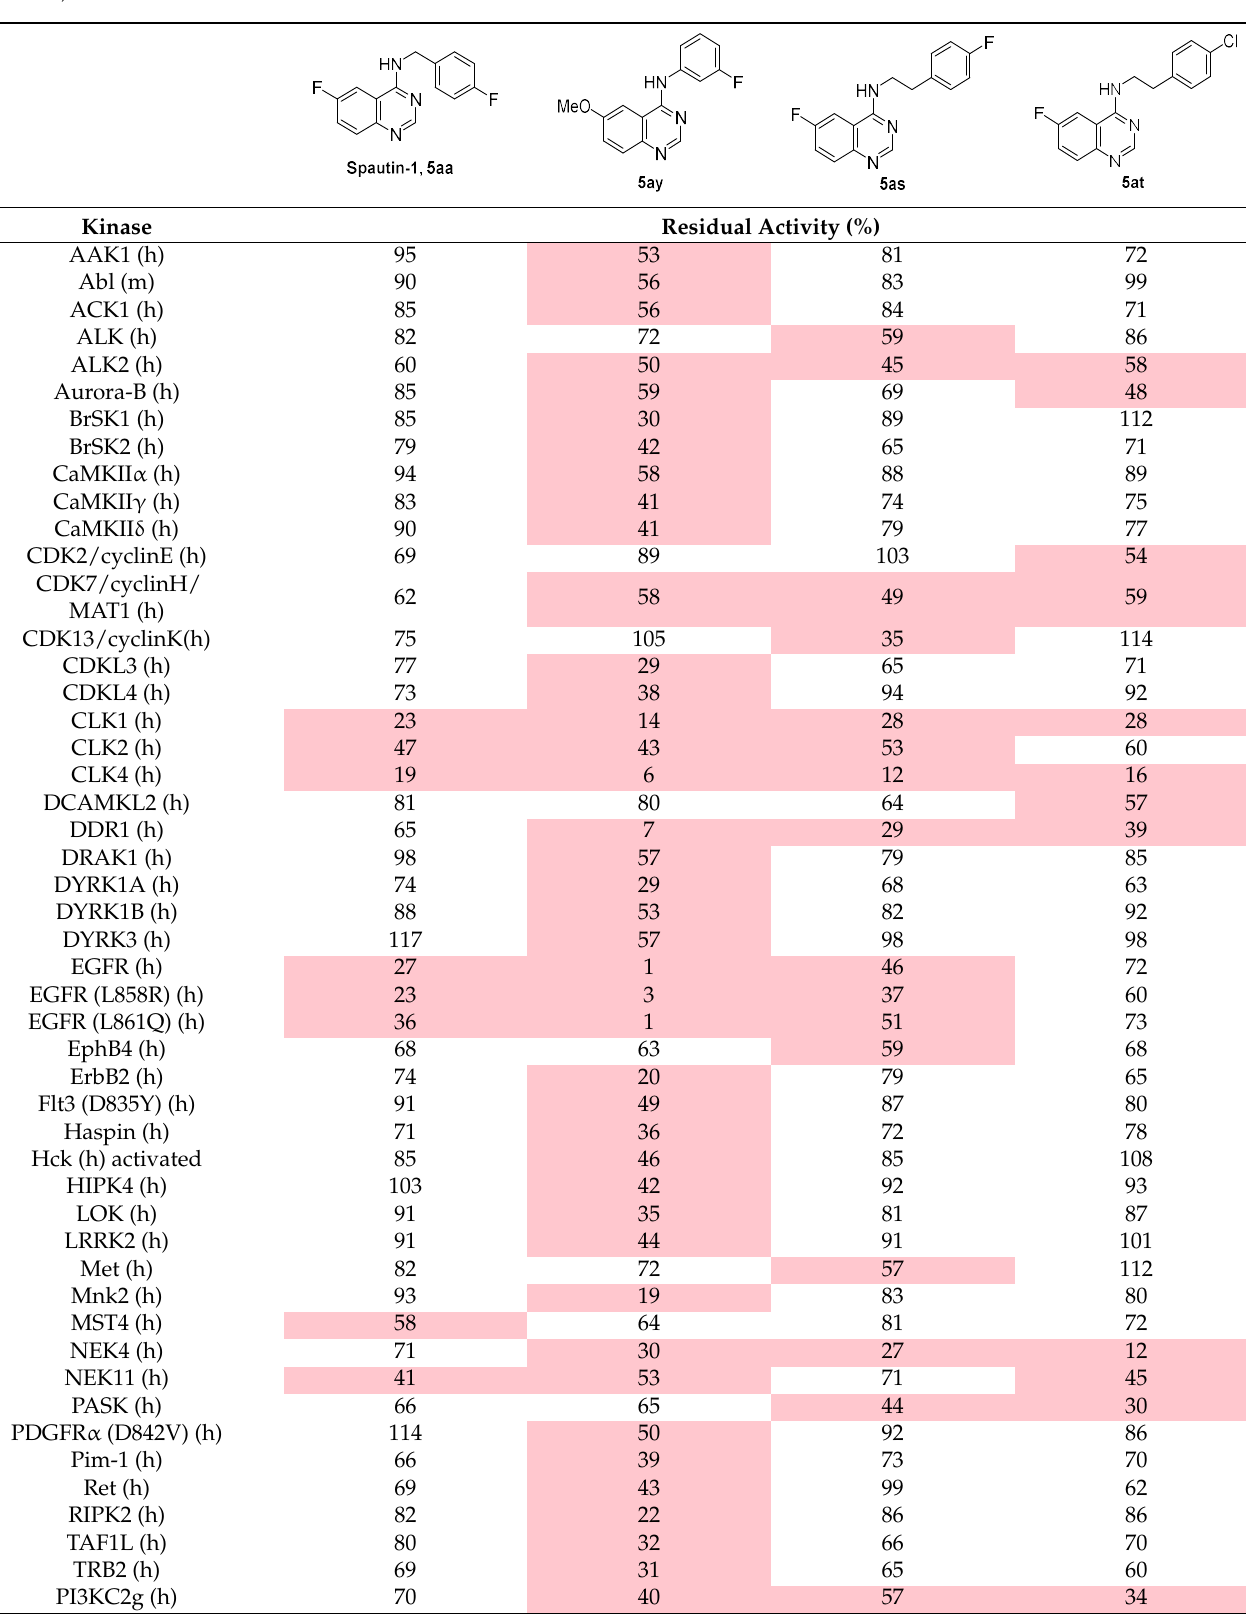
Table 2. Kinases which had a residual activity < 60% for at least one of the analogues at a 10 µM concentration (highlighted in red).